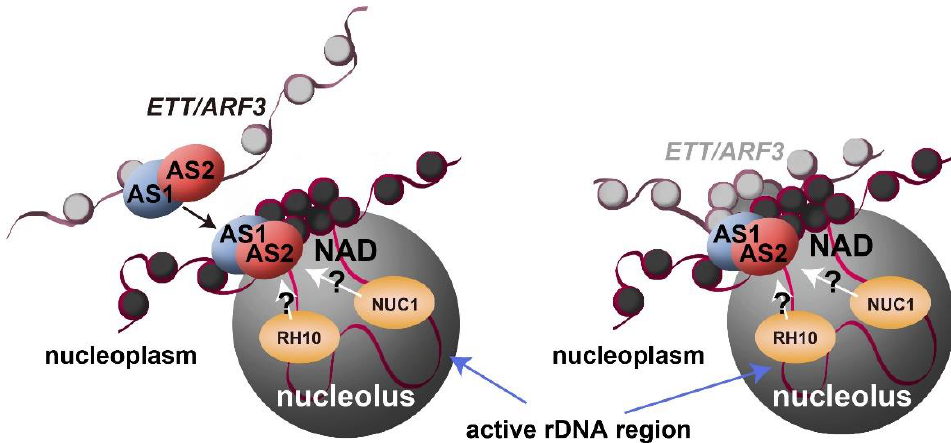
Figure 6. Models of the roles of nucleolar proteins in AS2–AS1 involved in epigenetic regulation of the ETT/ARF3 gene. Nucleolus and surrounding structures are shown. Nucleosomes are indicated by coiled structure composed of red lines (DNA) and light/dark grey circle (histone octamer). Different genomes are distinguished by different darkness of nucleosomes. NUC1 affected the localization patterns of AS2 bodies at the peripheral region of the nucleolus, which are required for leaf development. AS2 bodies are partially overlapped with chromocenters, represented by dense nucleosome at the peripheral region of the nucleolus. The 45S rDNA repeat loci include transcriptionally active and inactive regions, which chromosomal status are loosened in the nucleolus and condensed on the peri-nucleolus (overlapping with chromocenter), respectively, suggestive of an interaction of AS2 bodies with inactive 45S rDNA. RH10 and NUC1 in addition to AS2 are involved in the maintenance of CpG methylation in exon 6 of ETT/ARF3 in the nucleoplasm (left panel) or in AS2 bodies (right panel). NUC1 is involved in the maintenance of CpG methylation in 45S rDNA.